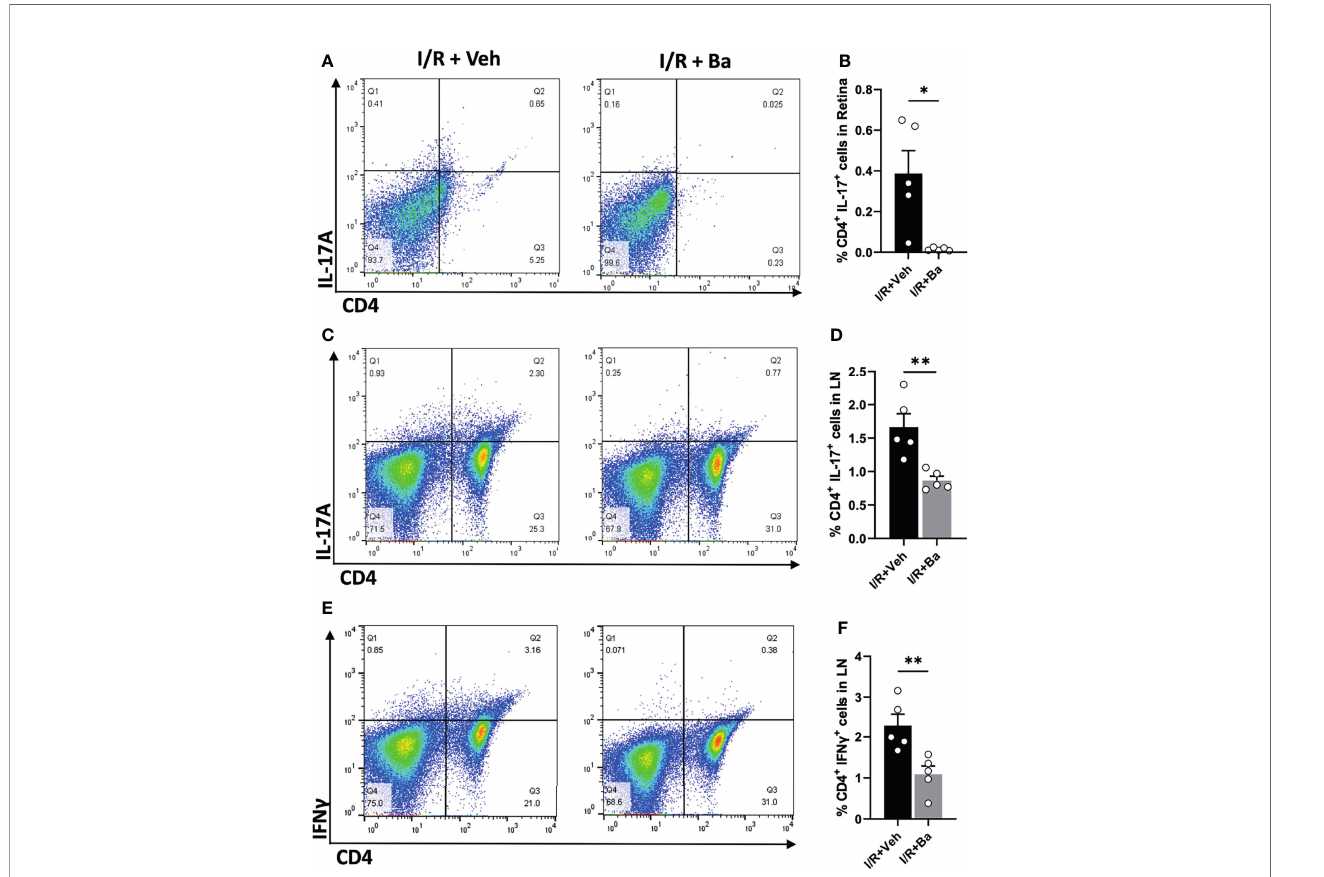
FIGURE 5 | Baicalein attenuates CD4 + Th17 and Th1 cell responses in the retina and superior cervical lymph nodes after I/R insults. (A) Representative FACS plots showing the gated population of CD4 + and IL-17A + T cells and (B) their frequency in the retinas from the Veh or 100 m M baicalein (Ba)-treated mice at 2 weeks I/R injury. (C) Representative FACS plot of CD4 + /IL-17A + T cells and (D) their frequency in the cervical lymph nodes (LNs) of the Veh or Ba-treated mice at 2 weeks post-I/ R injury. (E) Representative FACS plots and (F) the quanti fi cation of the frequency of CD4 + /IFN g + T cells in the cervical LNs of the Veh or Ba-treated mice at 2 weeks post-I/R injury. N = 5 per group. Data were presented as mean ± SEM. Each dot represented an individual replicate. * P < 0.05, ** P < 0.01, Student ’ s t